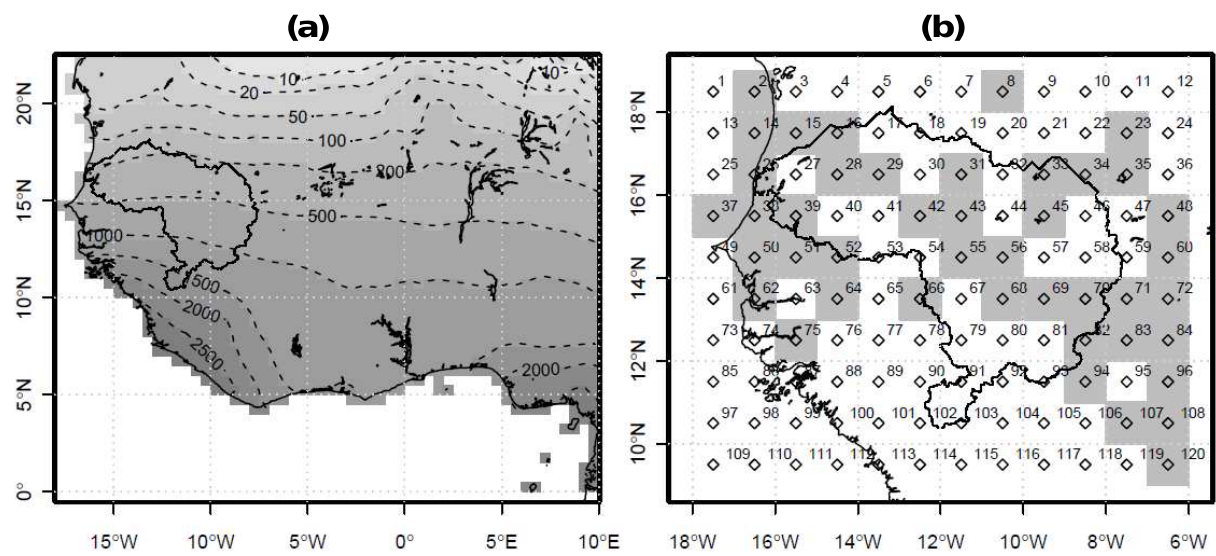
Fig. 1. Location of Senegal River Basin: (a) mean annual rainfall (mm) from Climate Research Unit database (CRU, University of East Anglia, Norwich, UK), over 1961–1990 period, and (b) sites selected for analyses, and The IRD sites are highlighted with gray